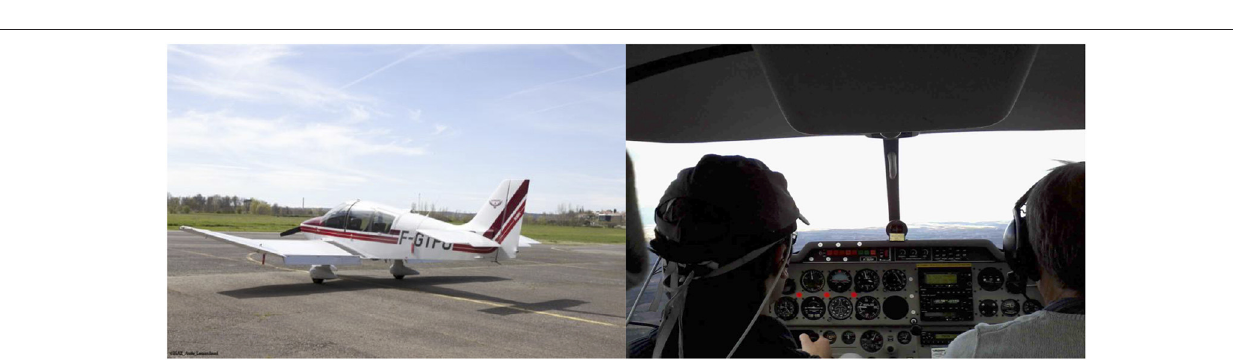
factors WM Load (High vs. Low) and ROI (#1, #2, #3 & #4);